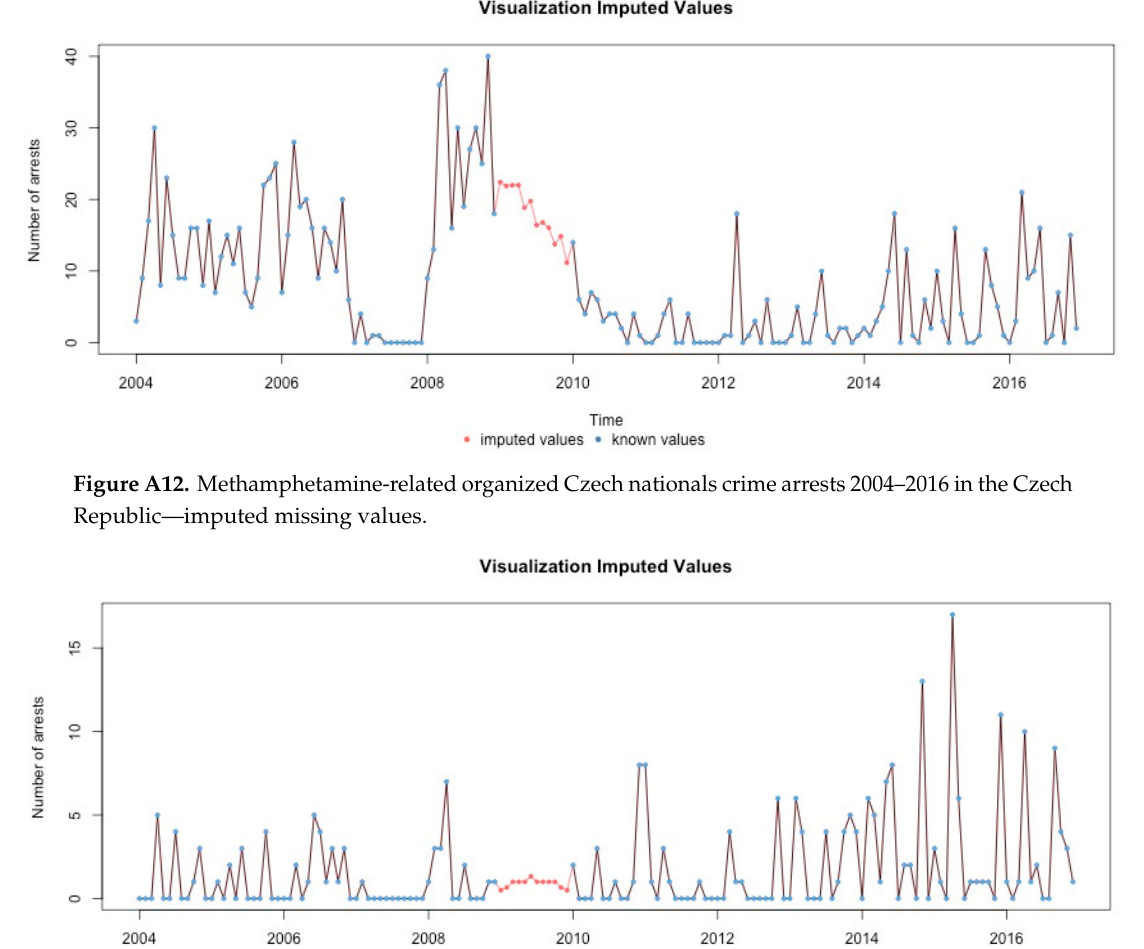
Figure A11. Methamphetamine-related organized crime arrests 2004–2016 in the Czech Republic – imputed missing values.